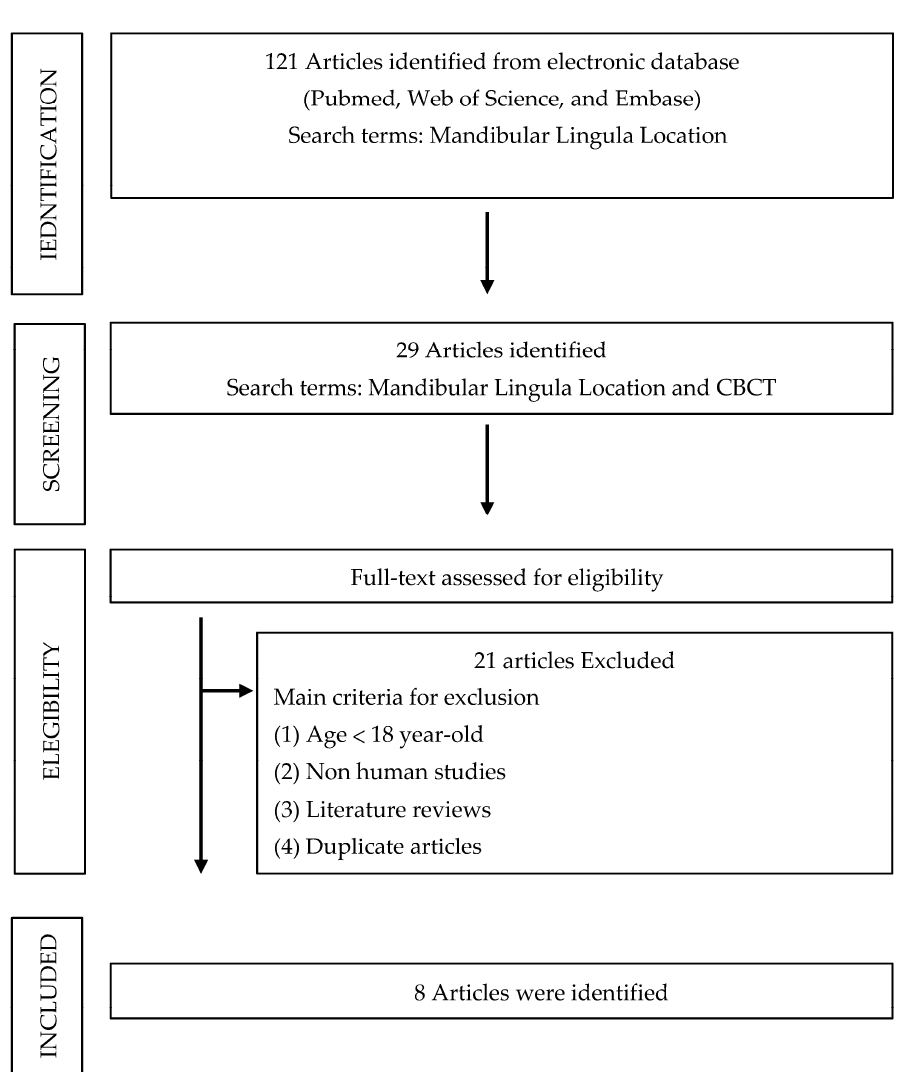
Figure 3. Process flow of article selection in the mandibular lingula location using cone-beam computed tomography.